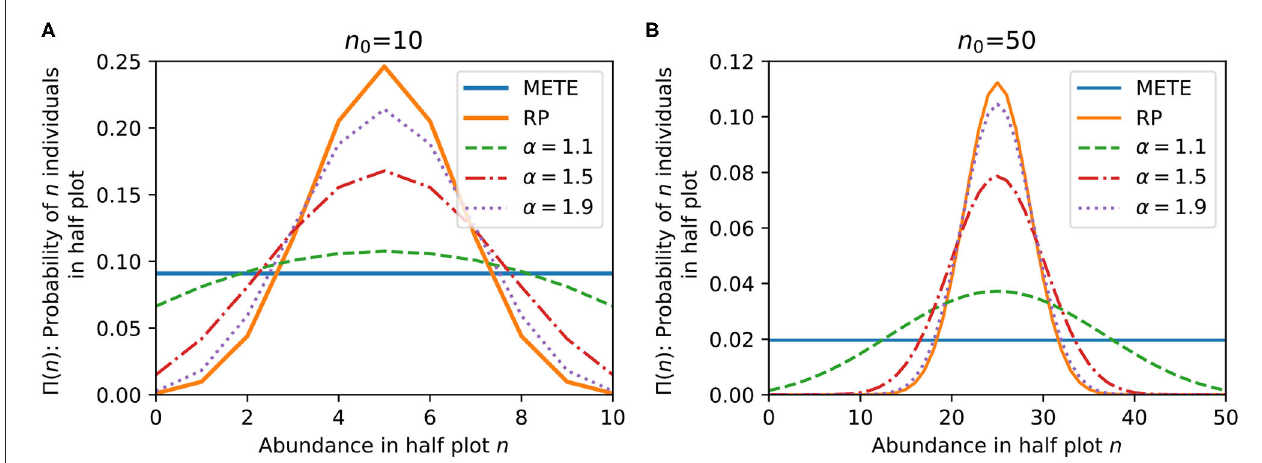
FIGURE 1 | Comparison of the bisection probability distributions 5 ( n ) from METE, random placement (RP), and our density dependent model with varying α at (A) n 0 10 and (B) n 0 50. At α 1, our model corresponds exactly to METE. At larger n 0 , α = = = continuously between METE and random placement for 1 < α <